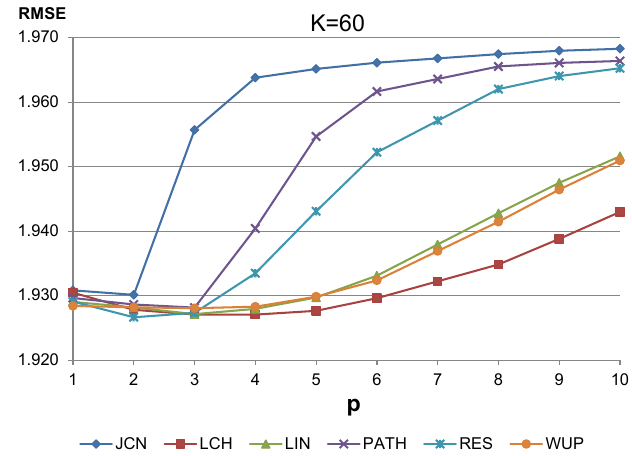
Figure 5. Behavior of softness control parameter p from Equation (8) in the OBF recommenders when the number of nearest neighbors k is fixed at